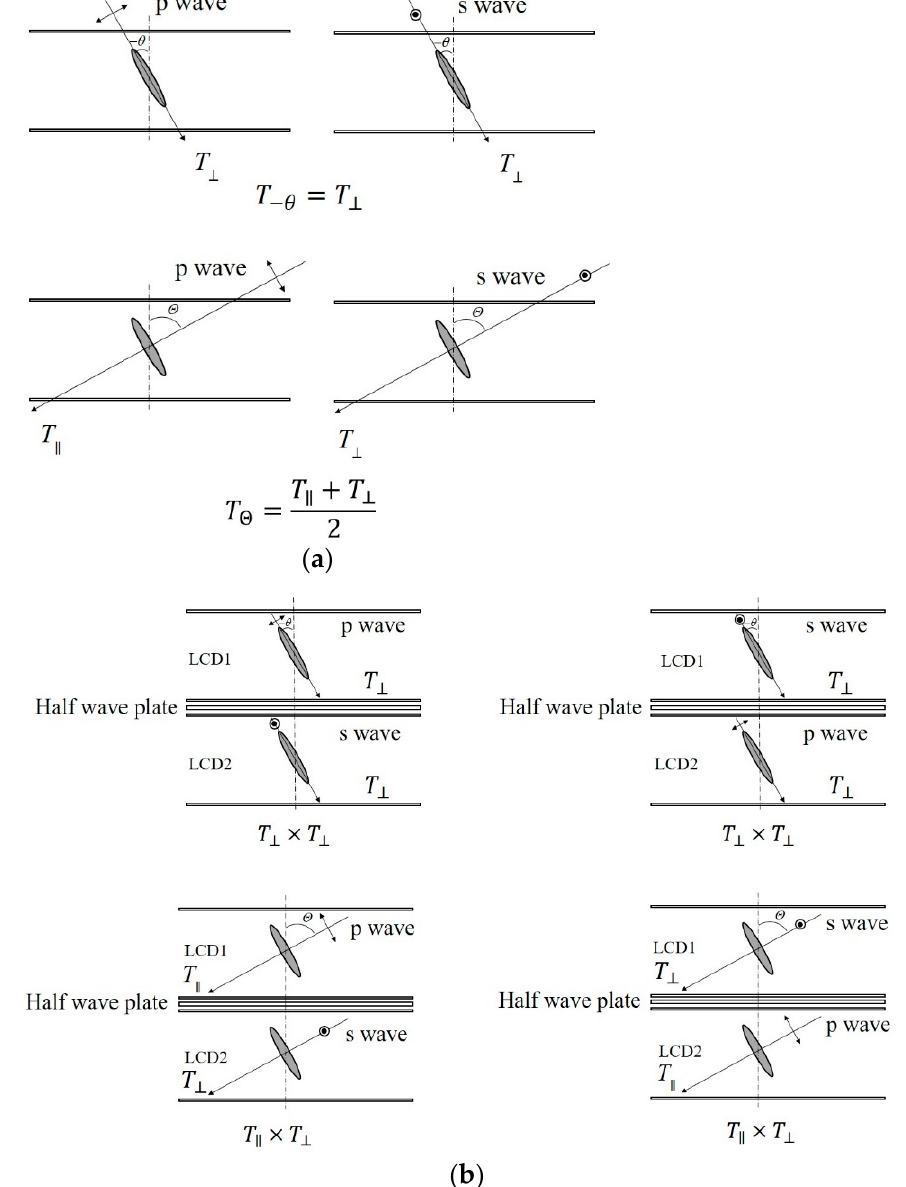
Figure 8. ( a ). Behaviors of p-waves and s-waves parallel and perpendicular to the dye molecules for single HAN-LCDs. ( b ). Behaviors of p-waves and s-waves parallel and perpendicular to the dye molecules for 2-layer HAN-LCDs.